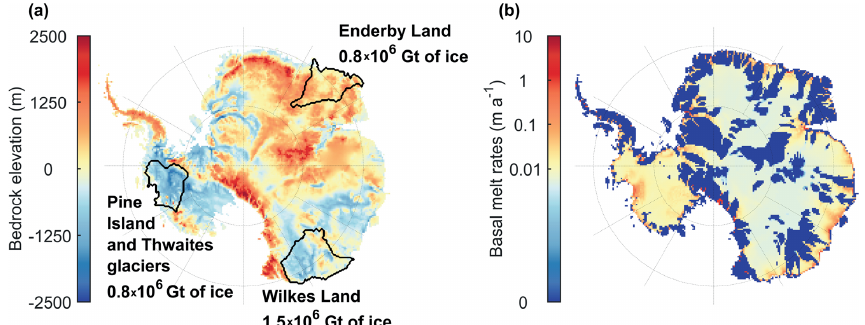
Figure 1. Bedrock elevation (m) based on BedMachine data (Morlighem et al., 2020) (a) and calculated basal melt rates (ma − 1 ) with the ice sheet model (b) . Selected drainage basins shown are discussed in Sect.